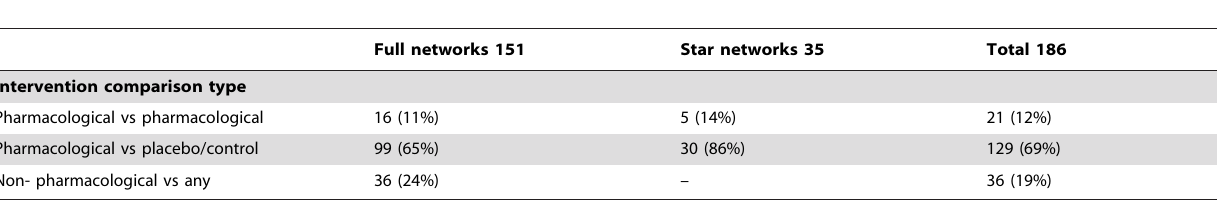
Table 5. Characteristics of the treatment comparisons in full and star networks published until 12/2012.